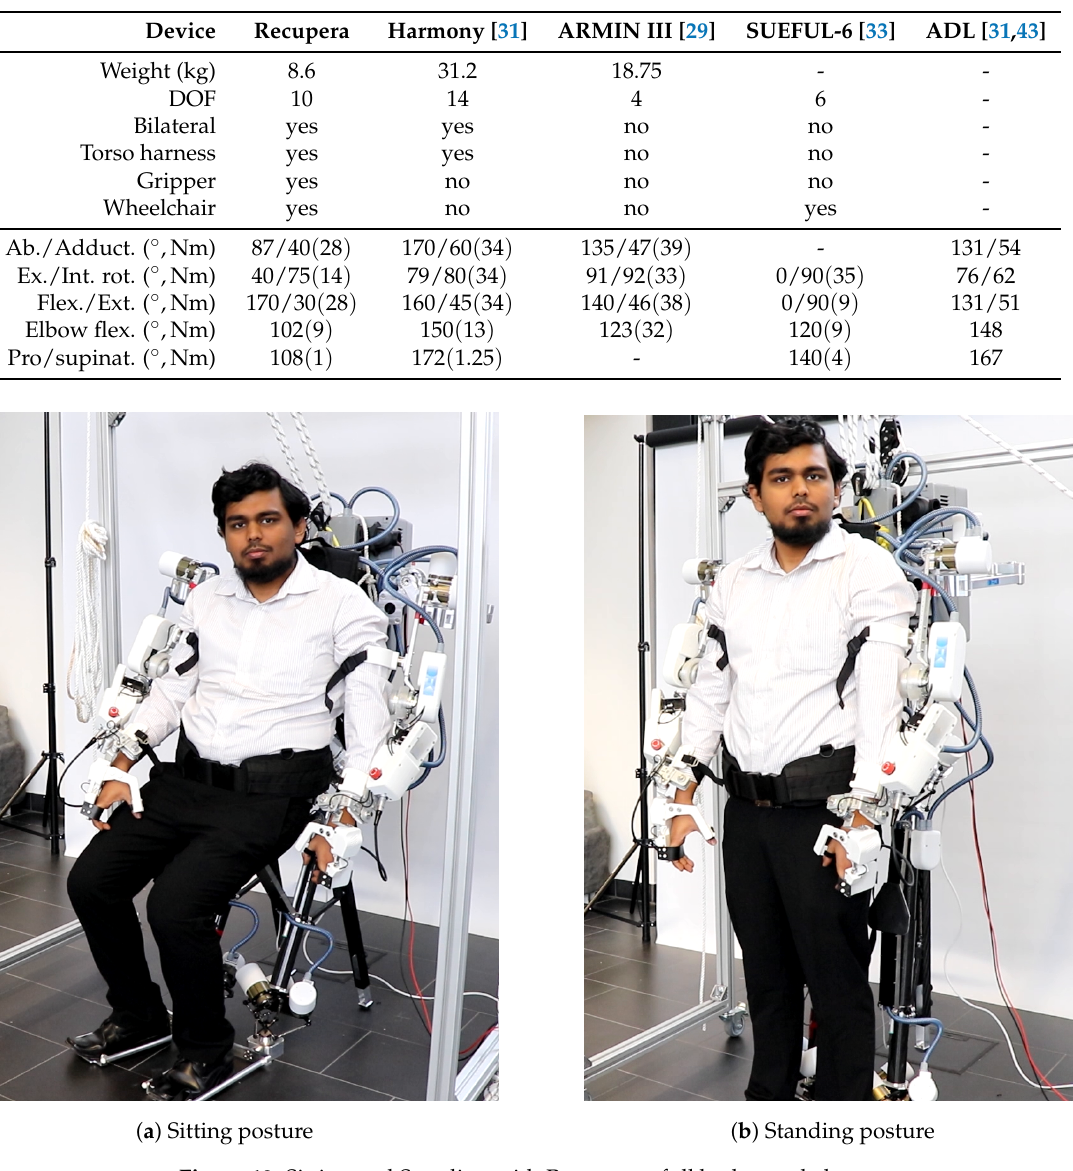
Figure 19. Sitting and Standing with R ECUPERA full body